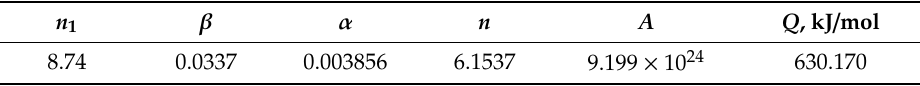
. ε . ε . ε Figure 3. Relationships of ( a ) ln   vs. ln σ , ( b ) ln   vs. σ , ( c ) ln   vs. ln[sinh( ασ )], ( d ) ln[sinh( ασ )] Figure 3. Relationships of ( a ) ln vs. ln σ , ( b ) ln vs. σ , ( c ) ln vs. ln[sinh( ασ )], ( d ) ln[sinh( ασ )] vs. vs. (1/ T ) and ( e ) ln Z vs. ln[sinh( ασ )]. (1 / T ) and ( e ) ln Z vs. ln[sinh( ασ )]. Table 2. Calculated material constants and deformation activation energy for Table 2. Calculated material constants and deformation activation energy for Waspaloy.